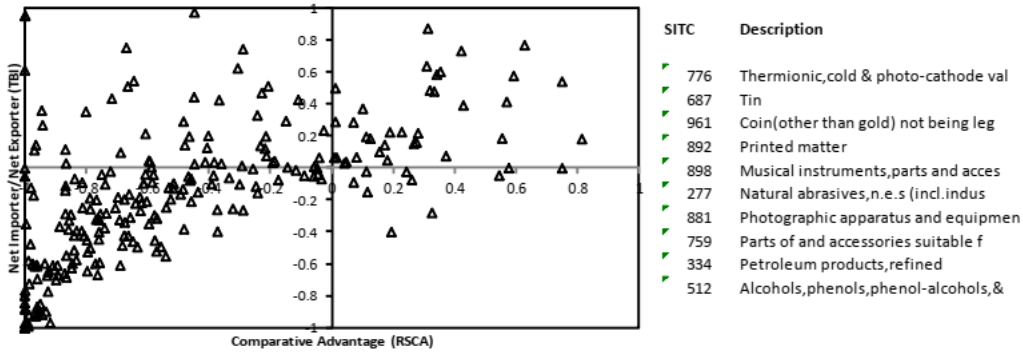
Figure 14: Products Mapping and the Top-Ten Export Products of Singapore, 1997